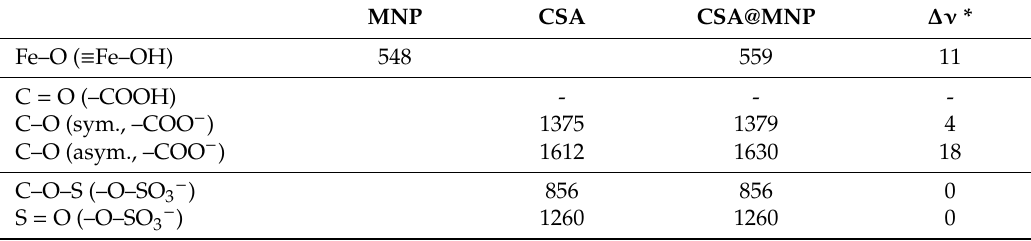
Table 1. Characteristic IR bands and their shifts (cm − 1 ) due to the CSA-adsorption on magnetite nanoparticles at pH ~6.3 and 10 mM NaCl.